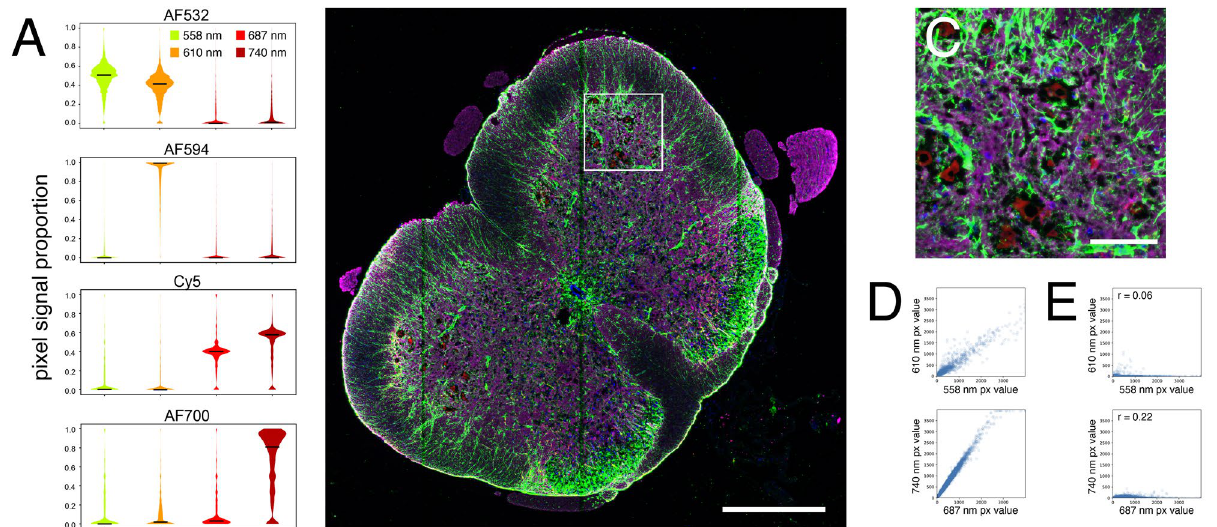
Figure 2. Simultaneous 4 channel imaging using PySeq2500. ( A ) Distribution of pixel signal intensity proportion across all detection channels from each fluorophore used for 4 channel imaging. ( B ) Mouse spinal cord stained simultaneously for LMNB1, GFAP, MBP, and ELAVL2 with fluorophore crosstalk removed using PICASSO unmixing strategy. Scale bar represents 500 μm. ( C ) Inset of B. Scale bar represents 100 μm. ( D ) Pearson correlation coefficient, r, of pixel intensities between corresponding detection channels prior to unmixing from singleplex staining of (top) LMNB1 with an AF532 conjugated secondary antibody and (bottom) MBP with a Cy5 conjugated secondary antibody. ( E ) Pearson correlation coefficient of pixel intensities between corresponding detection channels after linear unmixing of signal from singlex staining of (top) LMNB1 with an AF532 conjugated secondary antibody and (bottom) MBP with a Cy5 conjugated secondary